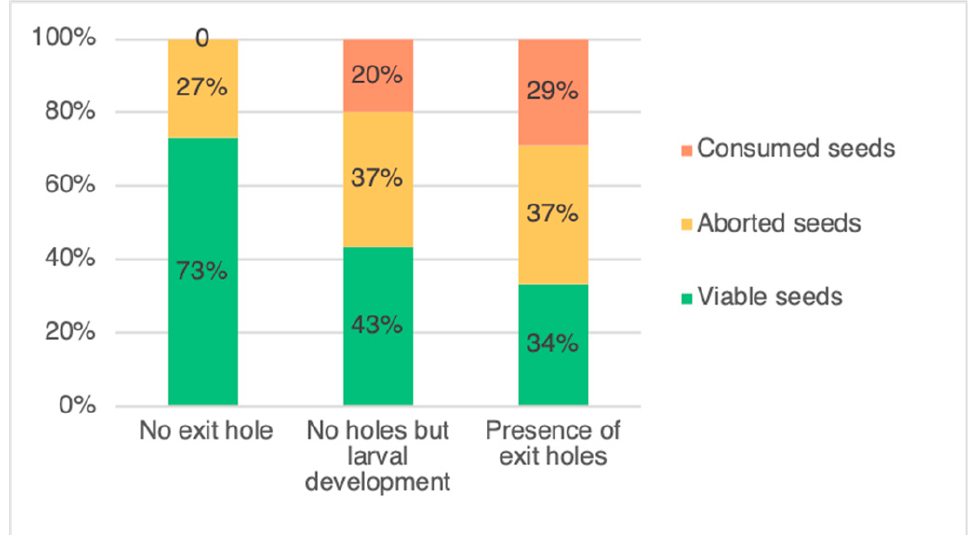
Figure 1. Infestation status of the three categories of pods of Genista monspessulana : pods with no exit hole and not infested by Lepidapion argentatum, pods with no exit hole but infested by L. argentatum (no adult emergence), and pods having at least one exit hole (adult